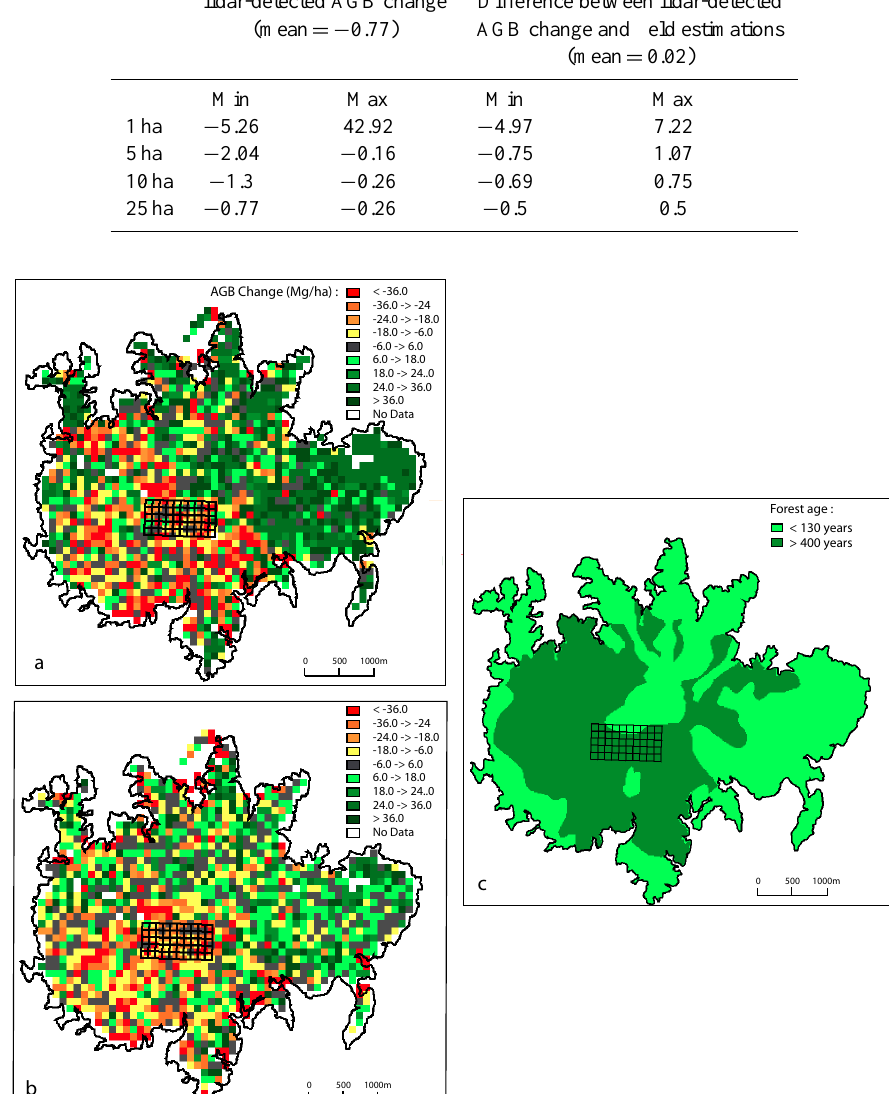
forest gained biomass ( 1 AGB Sec = 18.4 Mg ha − 1 ± 33.6 (SD)). The results show that 73 % of the 1 ha areas that lost more than 18.5 Mg ha − 1 (standard deviation of lidar-derived AGB change for this model) are located in old growth forest, while the remaining 27 % are located in secondary forest. In- versely, only 26 % of the 1 ha areas that gained more than 18.5 Mg ha − 1 are located in old growth forest, while the re- maining 74 % are located in secondary